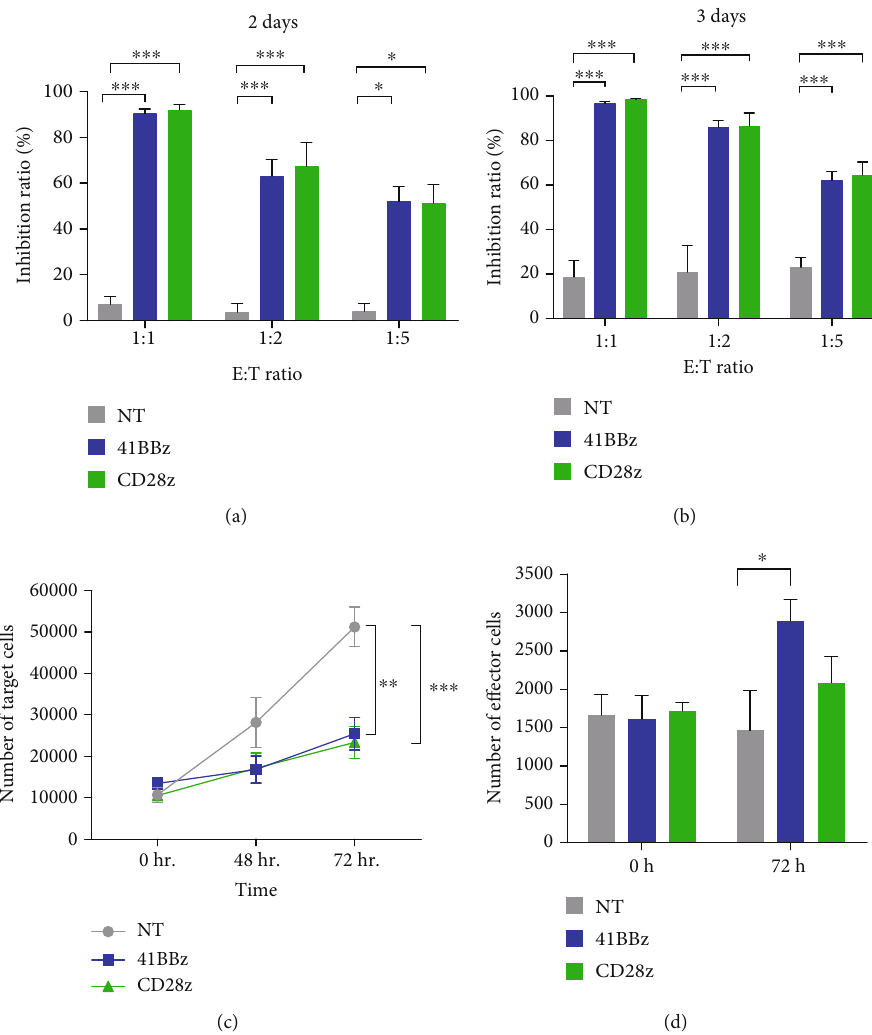
Figure 4: CAR.MUC1-41BB ζ and CAR.MUC1-CD28 ζ exhibit potent antitumor activity in vitro. CAR.MUC1-41BB ζ and CAR.MUC1-CD28 ζ were cocultured with MUC1 + breast cancer cell line, MCF-7 coexpressing eGFP at e ff ector: target (E:T) ratio 1:1, 1:2, and 1:5 without adding cytokine for 2 and 3 days. At the indicated timepoint, a number of tumor cells and T cells were determined by fl ow cytometry using counting beads. The inhibition ratio of CAR.MUC1-41BB ζ and CAR.MUC1-CD28 ζ after 2 days (a) and 3 days (b) coculture is shown. Data represents mean ± SEM ( n = 6 ). Quanti fi cation of residual target cells (c) and e ff ector cells (d) after coculture with CAR.MUC1-41BBz or CAR.MUC1-CD28z at ratio E:T of 1:5. Data represents mean ± S : E : M ( n = 6 ). Statistical di ff erences were analyzed by two-way ANOVA. P value signi fi cance is indicated as ∗ for P < 0 : 05 , ∗∗ for P < 0 : 01 , and ∗∗∗ for P < 0 : 001